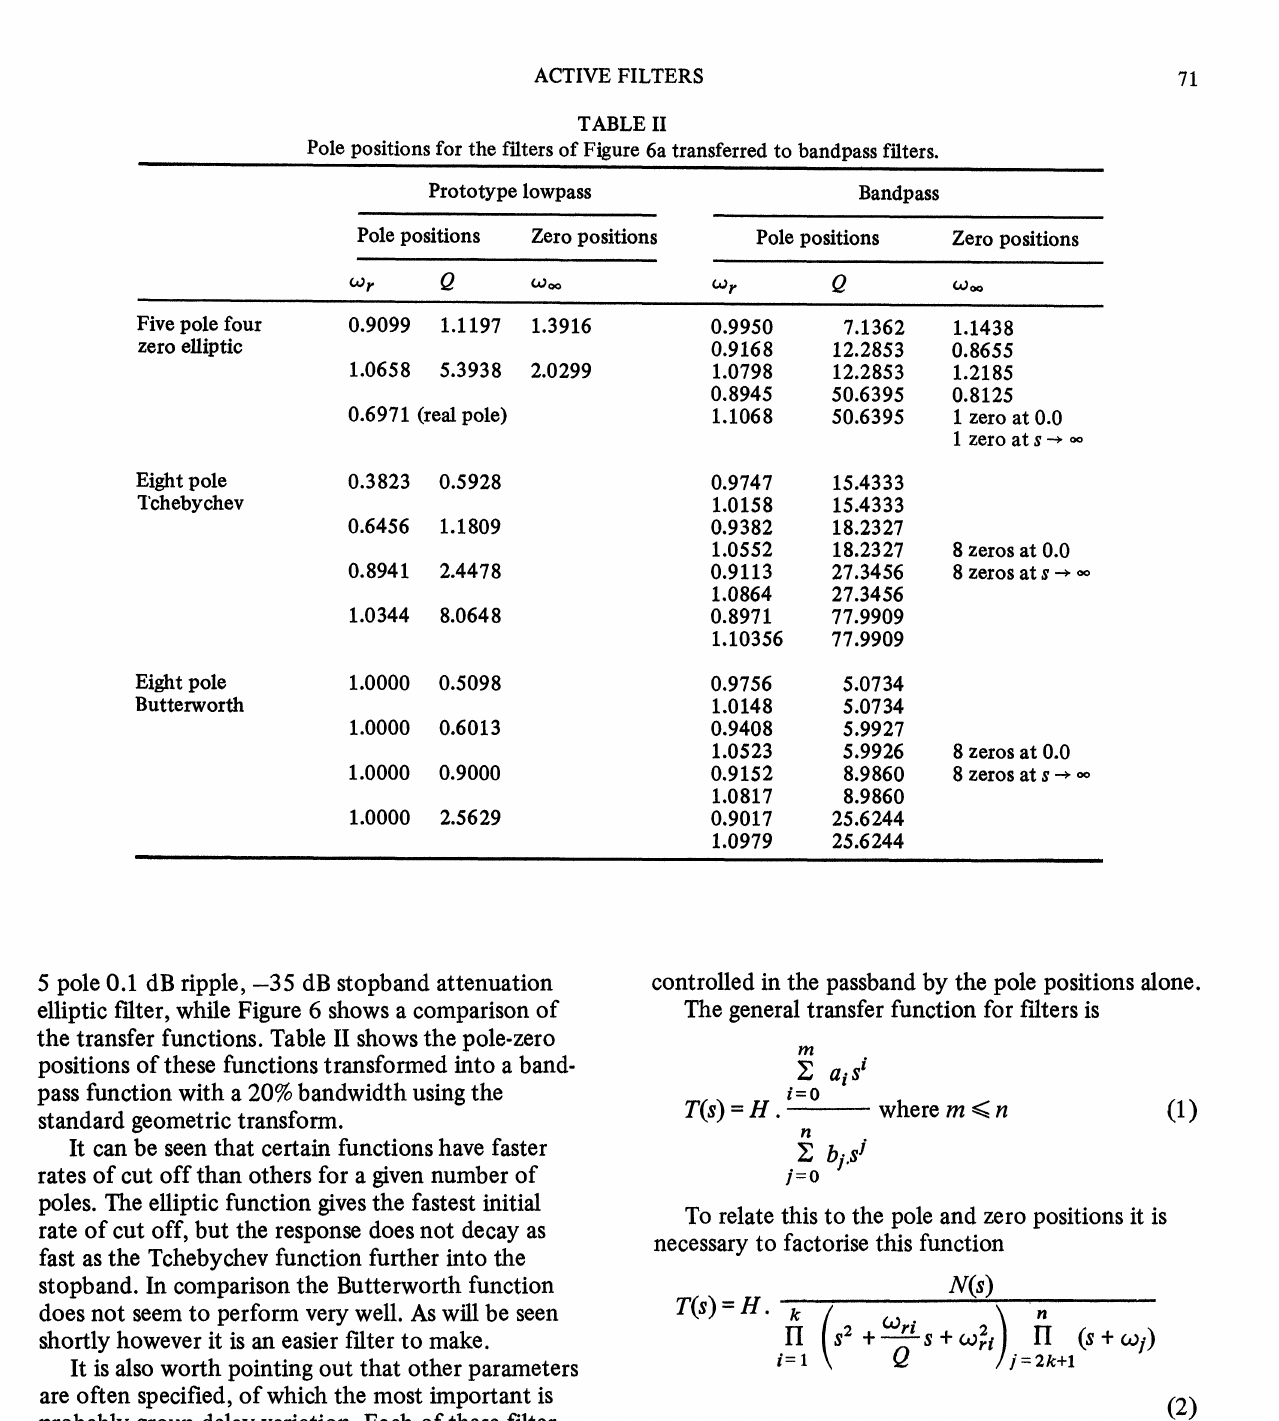
TABLE II Pole positions for the filters of Figure 6a transferred to bandpass